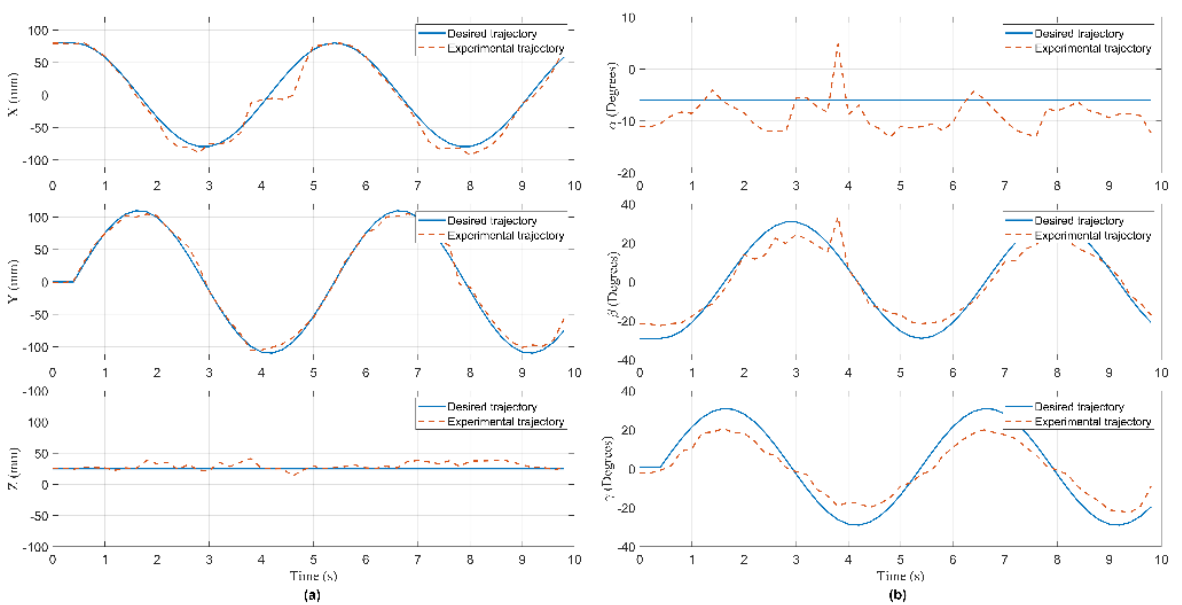
Figure 19. The pose of the end-effector in Case 3: (a) The position of the end- effector; (b) the orientation of the active plate.